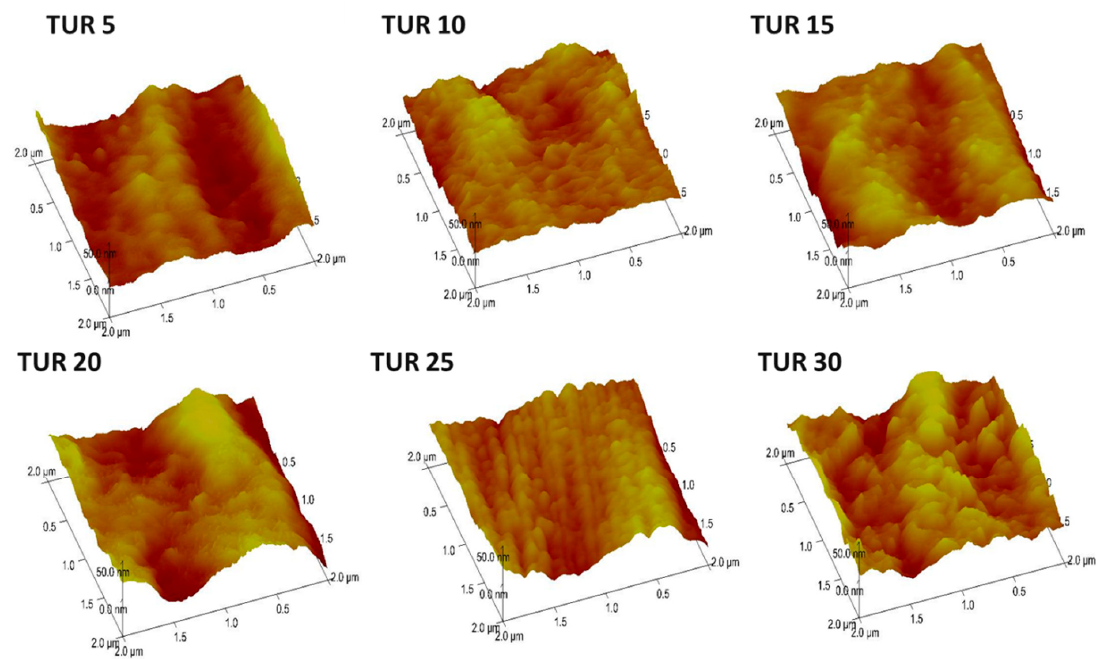
Figure 5. AFM height images of PE / EMAA films obtained at various TURs.